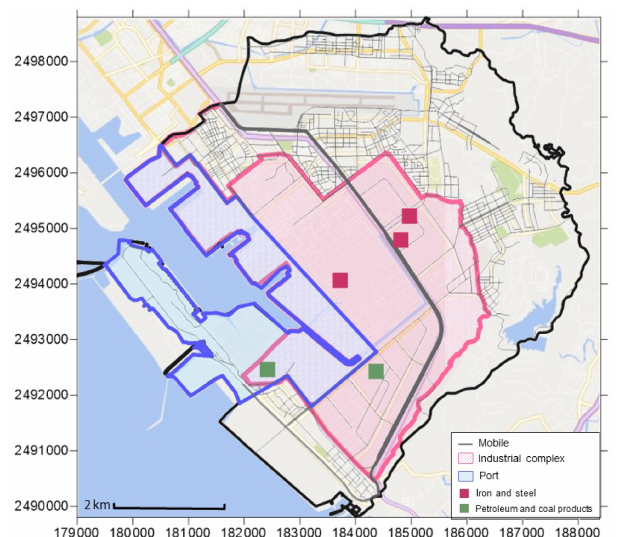
Figure 1. Major airborne emission sources in Xiaogang District (Map coordinates: longitude and